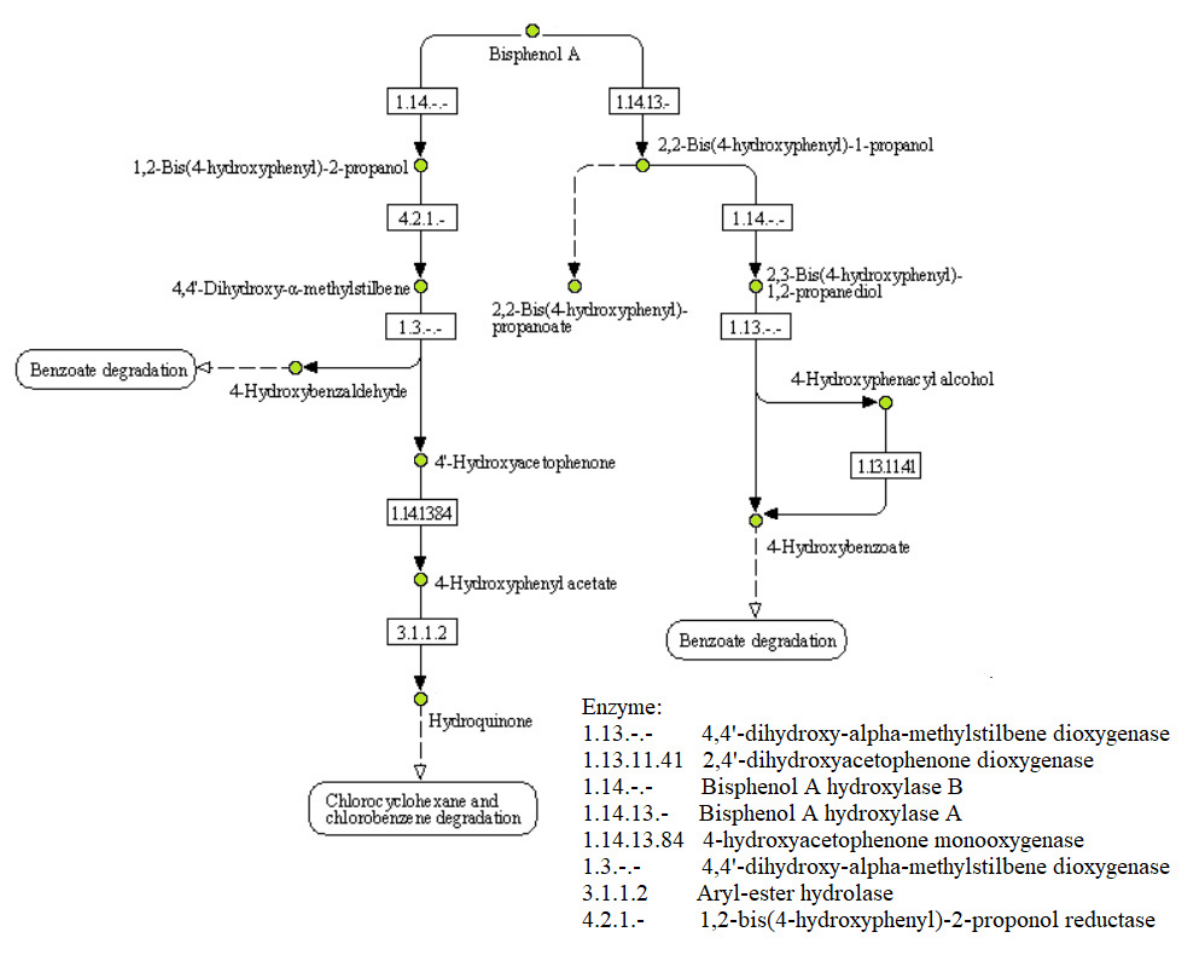
Figure 1. Pathways of BPA biodegradation [10].